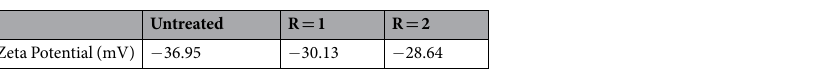
Untreated R = 1 R = 2 Zeta Potential (mV) − 36.95 Table 5. The zeta (surface) potential for two selected L-PPA:N samples in constant power of 20